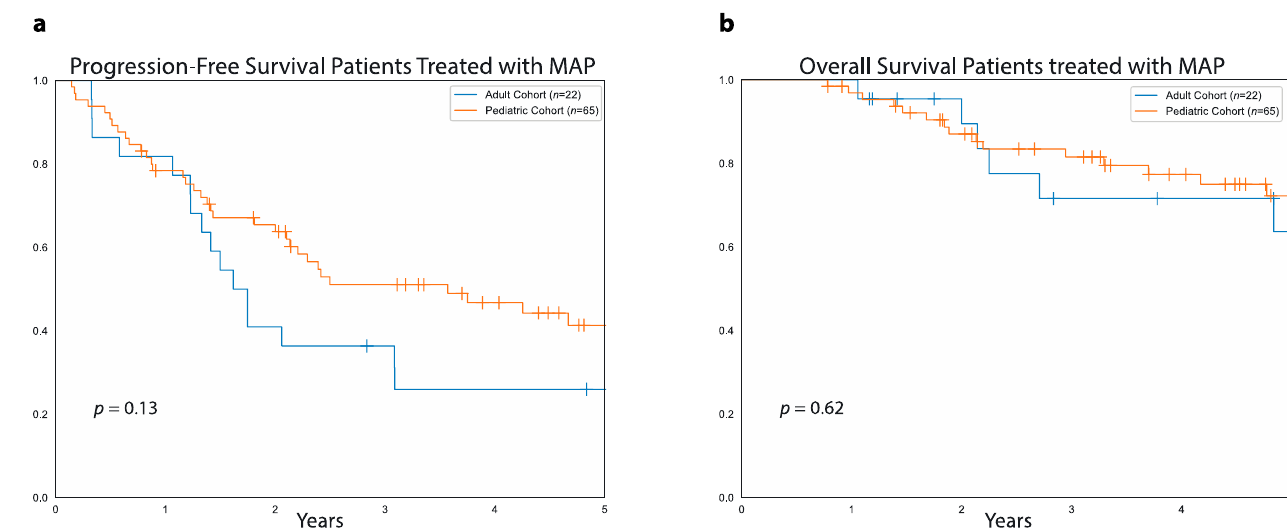
Figure 7. PFS and OS in pediatric and adult patients treated with MAP. ( a ) Data show progression-free survival for patients treated with MAP in the adult cohort (blue curve) and patients treated with MAP in the pediatric cohort (orange curve). ( b ) Overall survival for pediatric patients (orange curve) and adult patients (blue curve) treated with MAP.